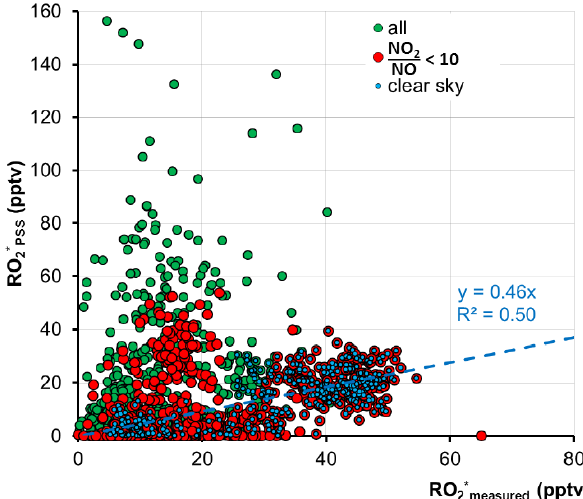
Fig. 9. RO 2* mixing ratios calculated from the photostationary state (PSS) versus RO 2* measured by the Fig. 9. RO ∗ mixing ratios calculated from the photostationary state DUALER. Data for maximum insolation periods between 10:00 and 16:00 UTC (blue dots) and for 2 (PSS) versus RO ∗ measured by the DUALER. Data for maximum NO 2 /NO <10 (red dots) are highlighted. 2 insolation periods between 10:00 and 16:00UTC (blue dots) and for NO 2 /NO < 10 (red dots) are